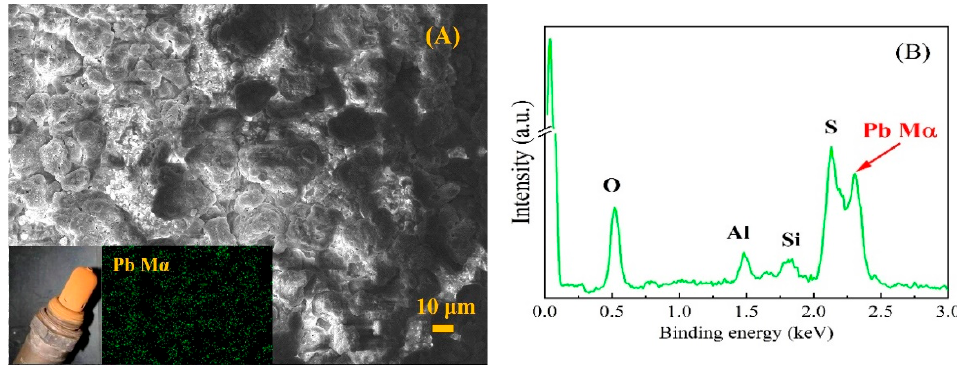
Figure 1. The appearance of a failed sensor ( A ), as well as its surface morphology and Pb distribution ( B